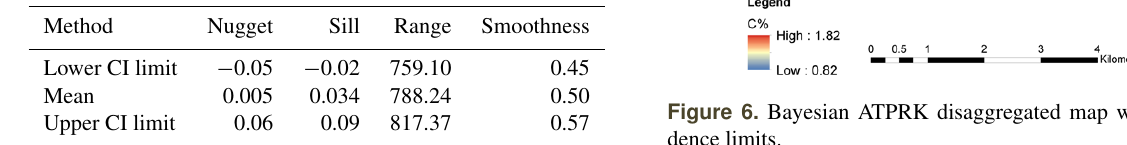
Figure 5. (a) Correlations and posterior distributions of variogram parameters (b) and the point and block support variograms. Table 2. Posterior parameters of the point support Matérn vari- ogram model. CI refers to the confidence interval.